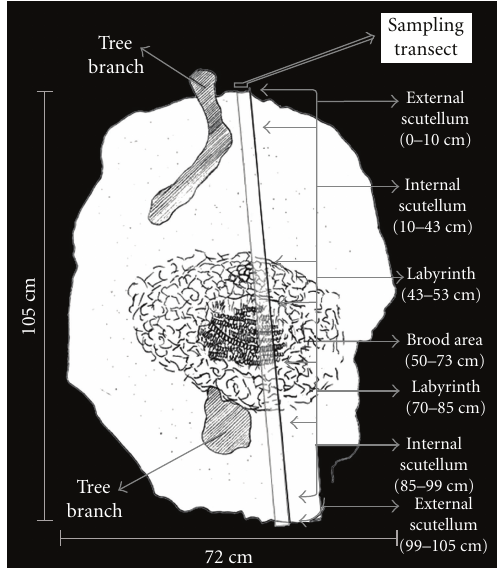
Figure 2: Diagram of scutellum and entire nest of Trigona corvina and the sampling